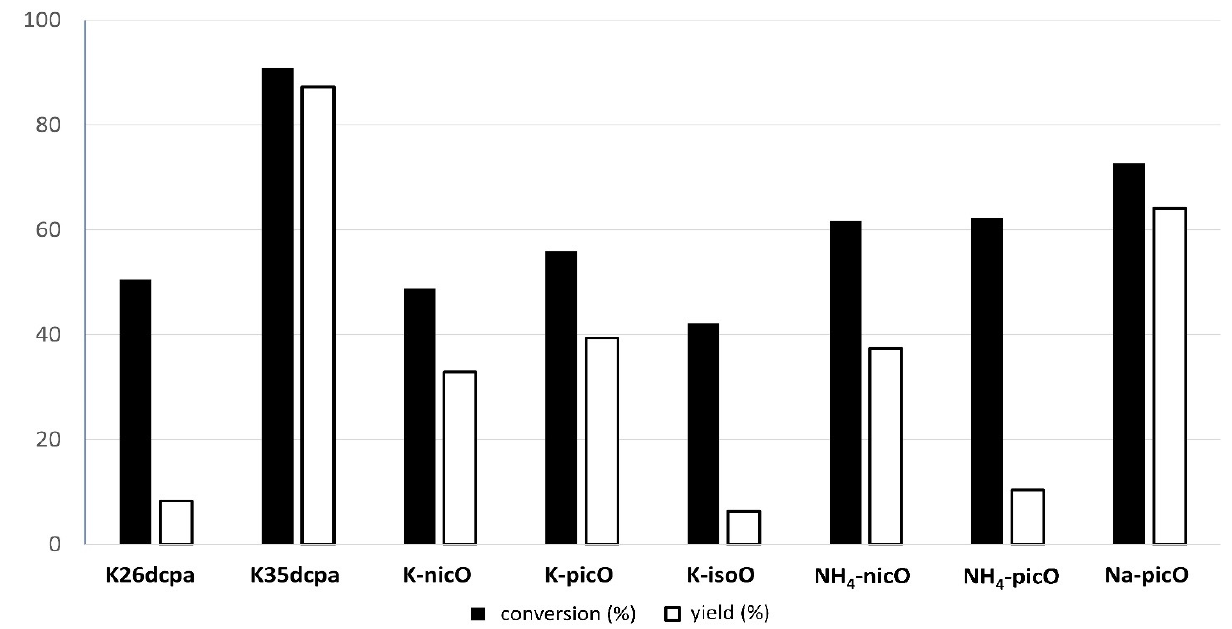
Figure 8. The BV oxidation of cyclohexanone with peroxidocompounds as catalysts in the first run.